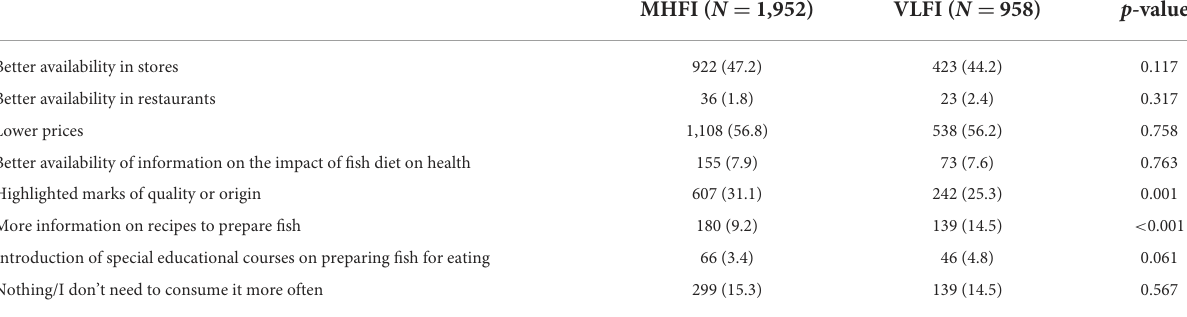
TABLE 3 Reasons for encouraging to consume more fish and fishery products among groups regarding the recommended fish intake ( N = 2,910).